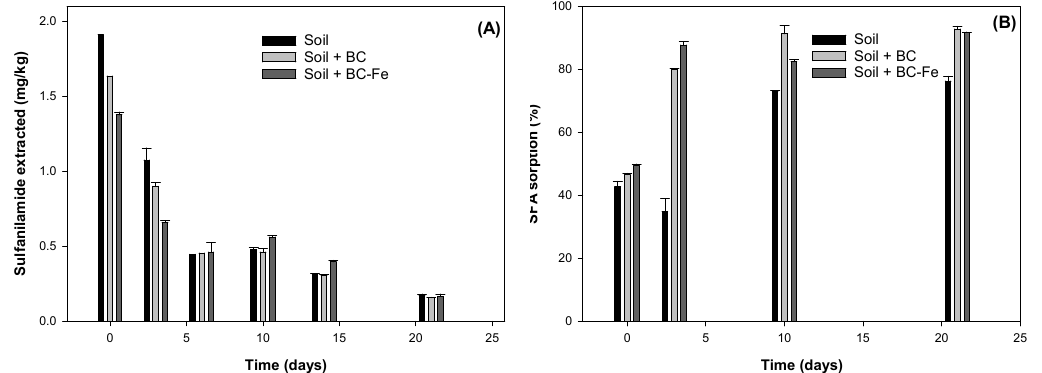
Figure 4. ( A ) Amount of sulfanilamide extracted in untreated soil and soil treated with BC and BC-Fe and ( B ) SFA sorption at selected times during the incubation experiment.